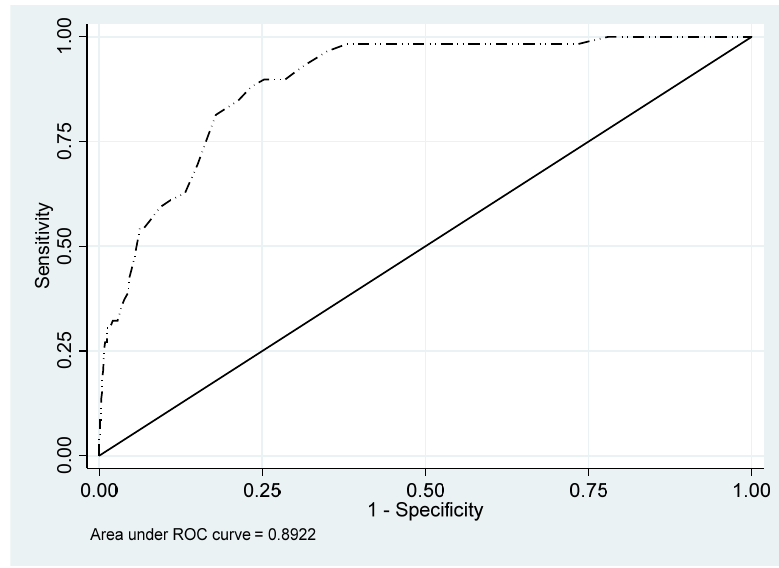
Figure 1. Total ROC (receiver operating curve) and AUC.